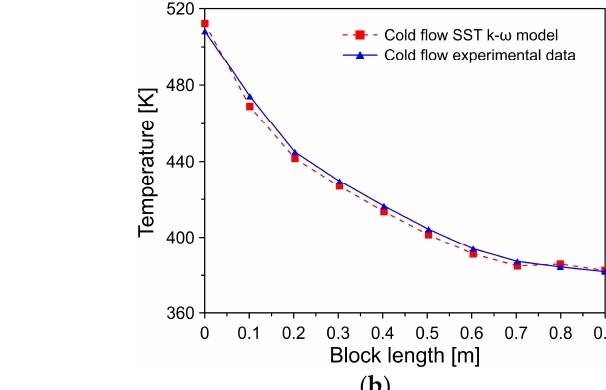
Figure 6. Numerical validation of the 𝑆𝑆𝑇 𝑘 − 𝜔 model and thermodynamic model: ( a ) hot flow; ( b ) cold flow.